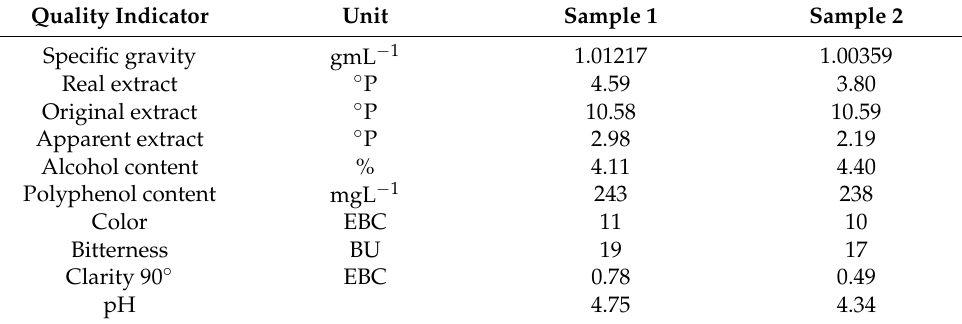
Table 3. Basic physical–chemical indicators of beer.